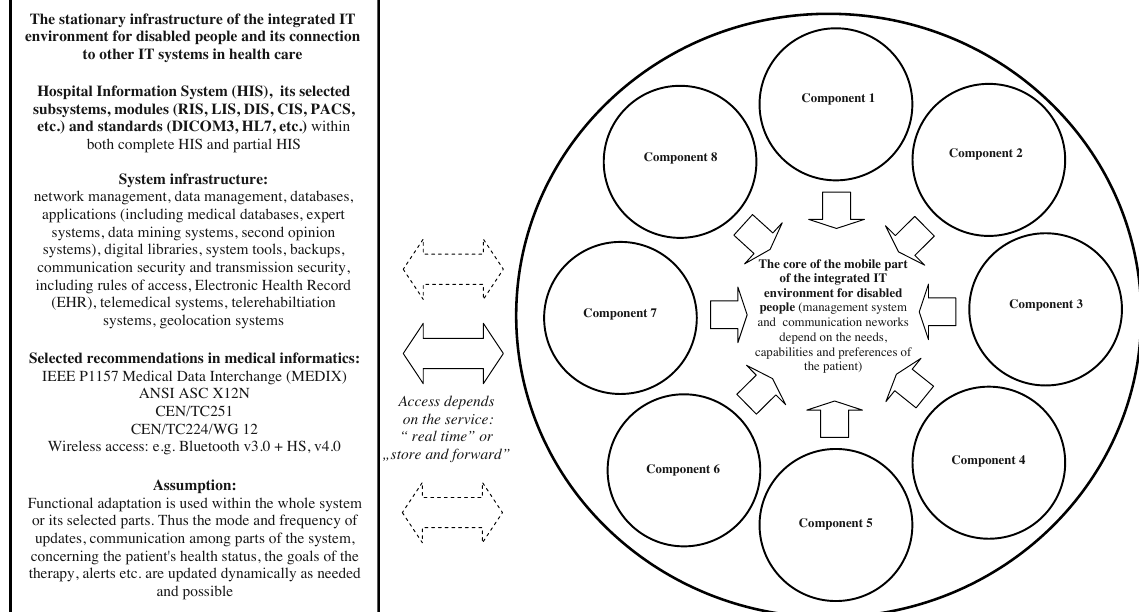
Figure 3. The concept of interaction in the integrated IT environment for disabled people